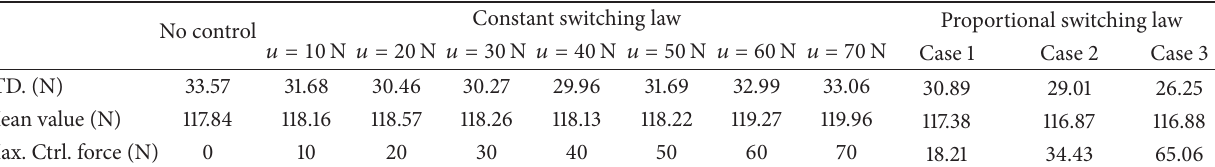
Table 2: The results of standard deviation and maximum control force.